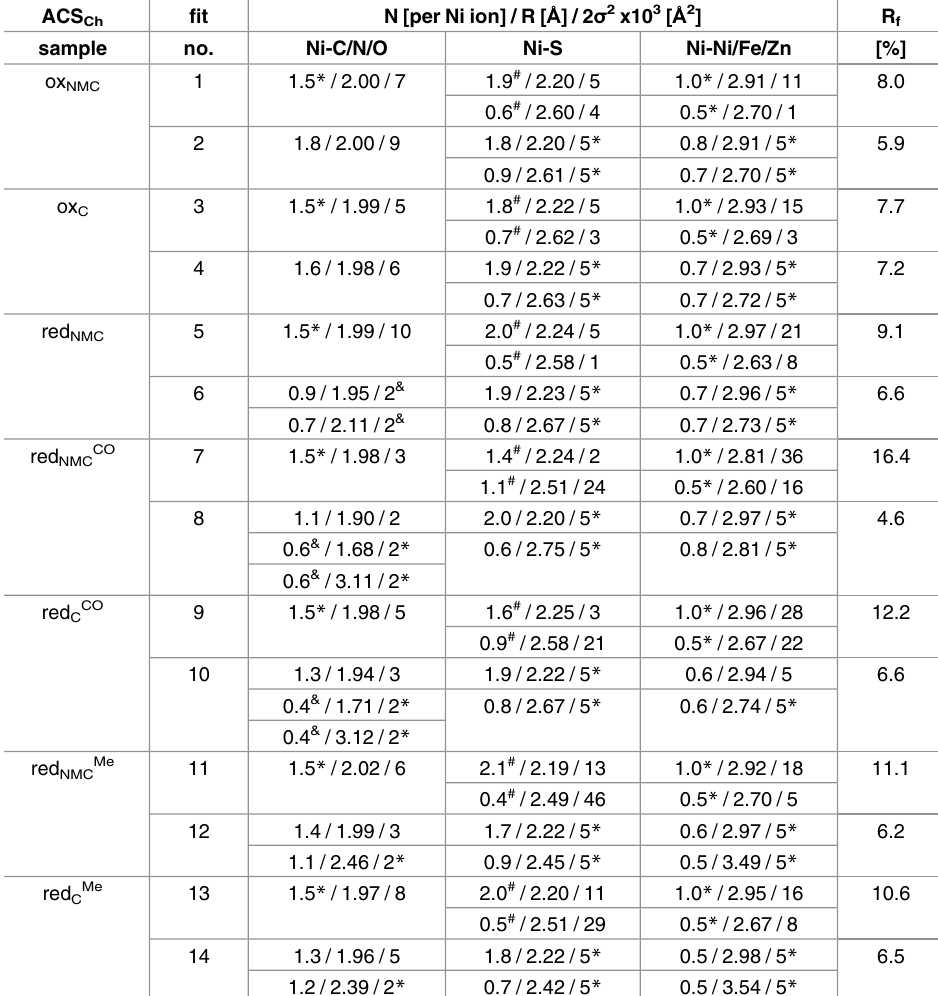
Table 2. EXAFS simulation parameters. a